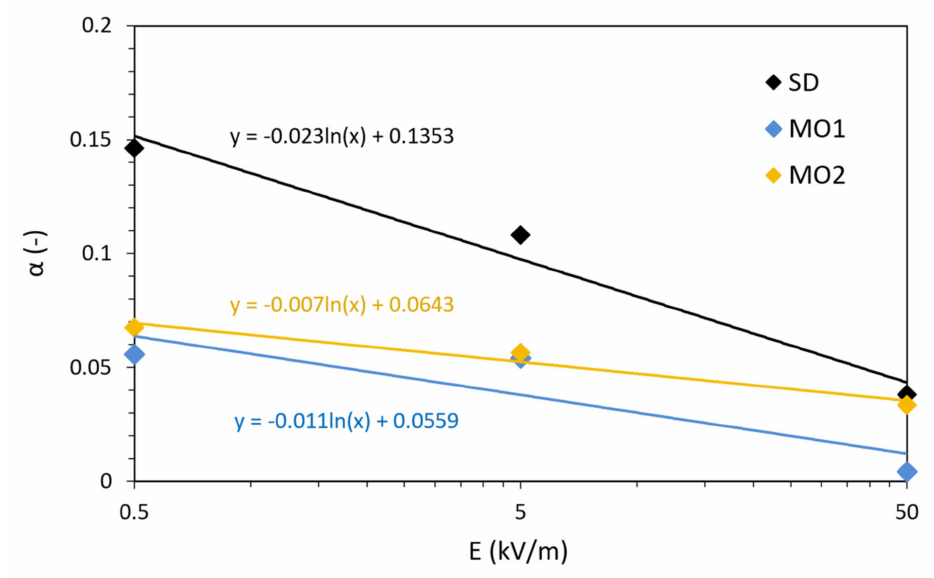
Figure 10. Regression lines of α parameter depend on the intensity E of the time-varying electric